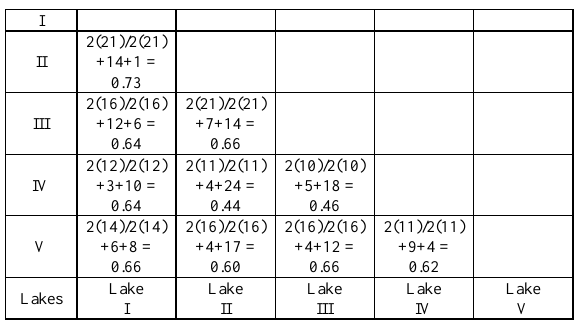
Table 7. Use of Sorenson’s coefficient to find similarity,